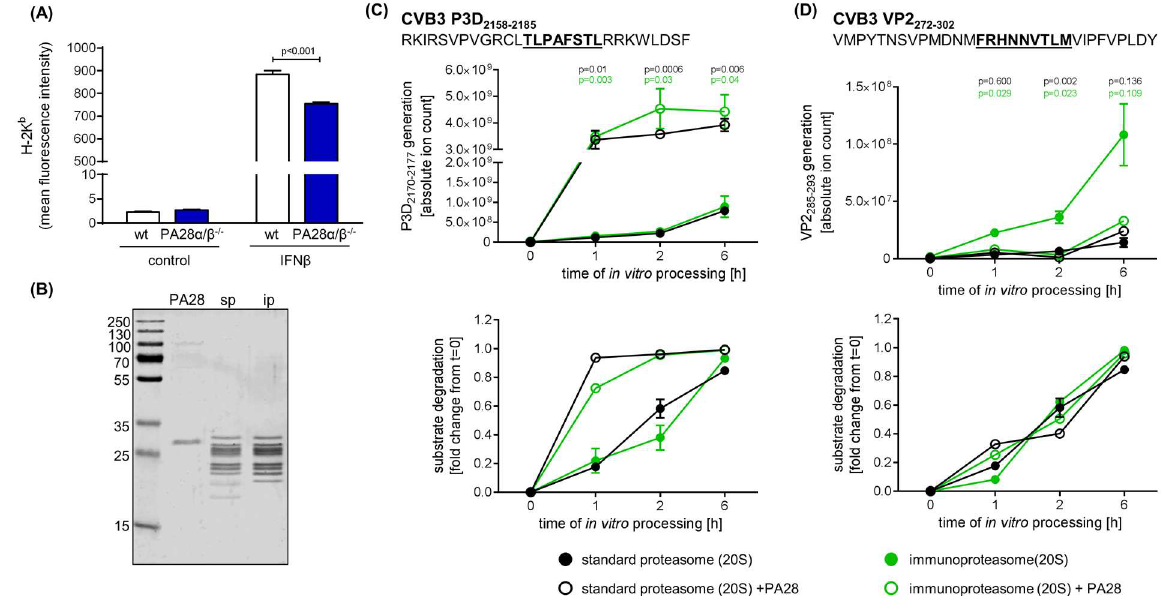
Fig 4. Influence of PA28 α / β on MHC class I antigen processing of CVB3 epitopes. (A) Murineembryonicfibroblastswere treated with IFN- β for 24 hours. For assessing MHC class I expression, cells were stained with anti-H-2K b mAb and analyzedby flow cytometry (mean + SEM, n = 3). (B) For in vitro peptideprocessingstudies PA28 from humanerythrocytes, 20S sp from human lymphoblasts (T2 cells) and 20S ip from stably LMP2/LMP7-transfected T2 cells (T27 cells) were purified. The purity of the preparations was examinedby Coomassiestainingof a SDS-PAGE gel. Two epitope-harboringCVB3 peptides—the 28-mer polypeptide P3D 2158-2185 (C) and the 31-mer polypeptide VP2 272-302 (D)–wereprocessedin the presenceof T2-derivedsp (filled black circles) and T27-derivedip (filled green circles) for the indicatedincubation periods. Open circles represent results of proteasome fragmentation studies in the presenceof PA28 for sp (black) and ip (green). The graphsin the upper panel summarizethe generation of the respectiveCVB3 epitopes (C) P3D 2170-2177 and (D) VP2 285-293 detected by ESI–MS/MS. The lower graphs depict the substrate degradationas fold changesof the ion counts at point in time = zero. All ion counts of peptidesubstrates were normalizedto the amount of the respectivesubstrate detected in the sp assay at point in time = zero. All data are means ± SEM of two technical replicates. Unpairedt-tests were performed at each point in time to compare ion counts for P3D 2170-2177 and VP2 285-293 in the absence (filled circles) or presenceof PA28 (open circles). All experiments shown are representative for at least two independentexperiments.